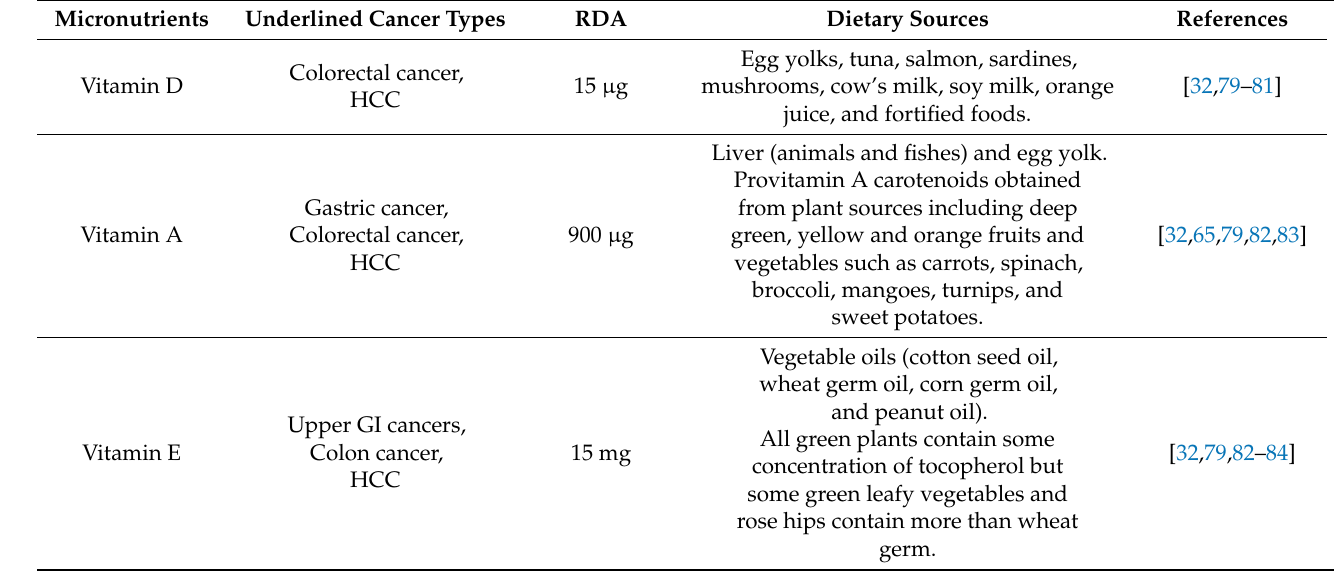
Table 1. Selected micronutrients associated with GI and hepatic